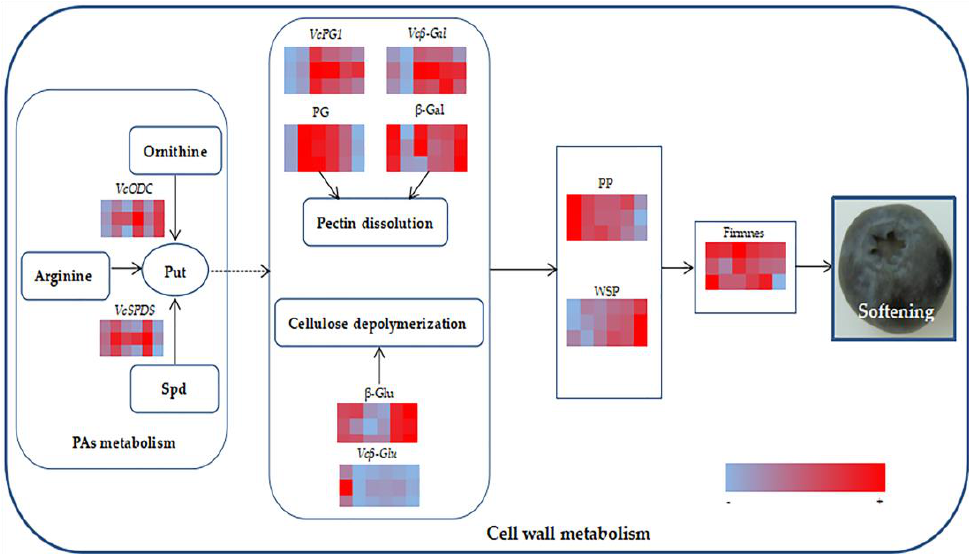
Figure 14. The potential model of exogenous Put treatment participating in cell wall metabolism and affecting blueberry fruit softening. Solid arrow presents direct regulation. Dotted arrow presents unclear regulation mechanism. Put: Putrescine. Spd: spermidine. PG: polygalacturonase. β−Gal: β−galactosylase. β− Gl u: β− glucosidase. PP: protopectin. WSP: water − soluble pectin.